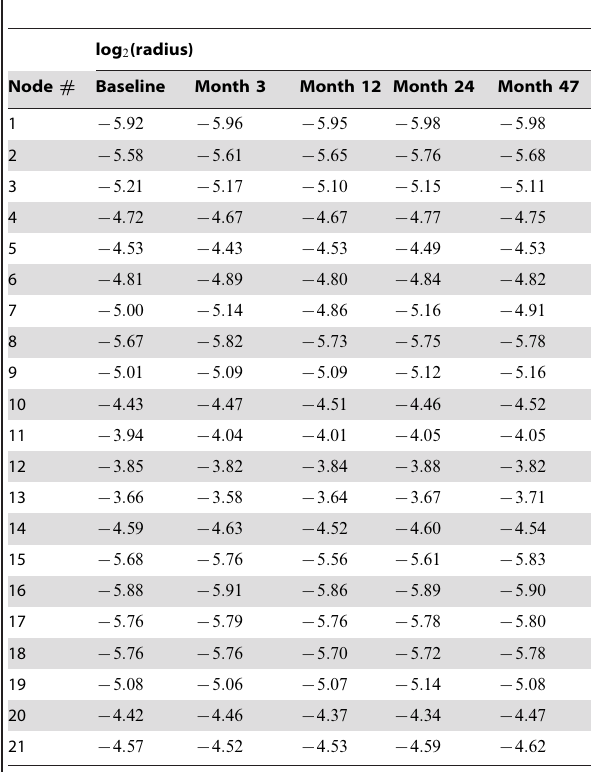
Table 2. Example subset of one subject’s data (Treatment - Olanzapine, Gender - M, Age -